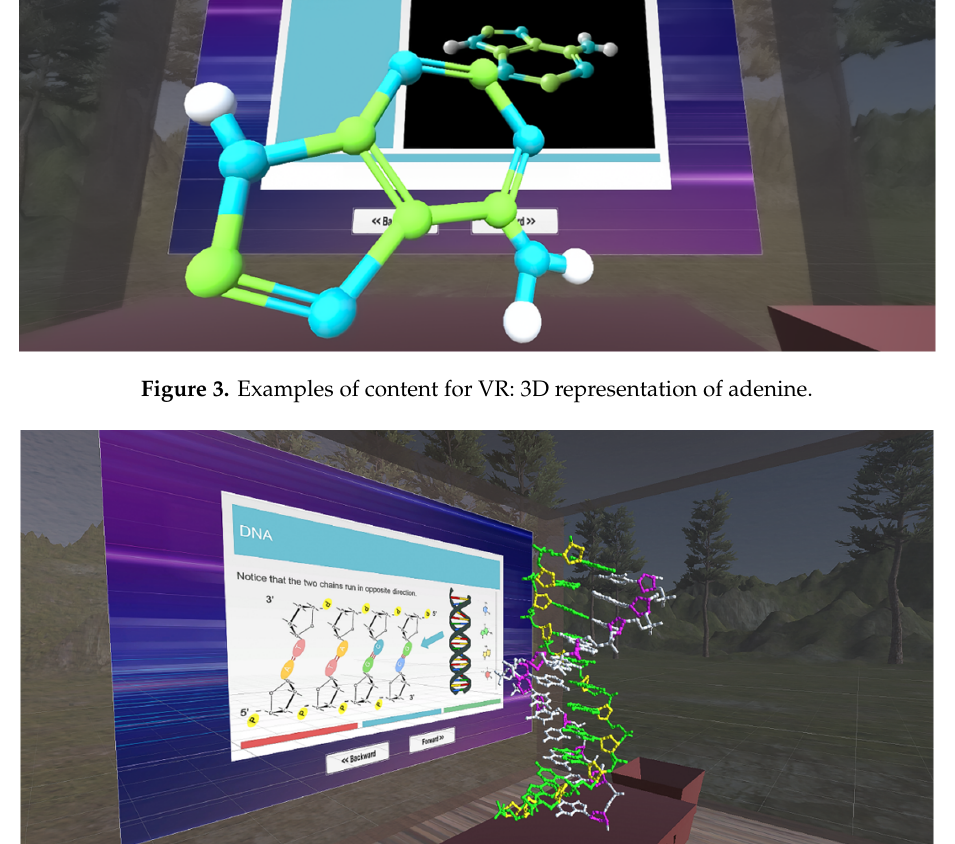
Figure 4. Examples of content for VR: 5’ ‐ end and 3’ ‐ end.